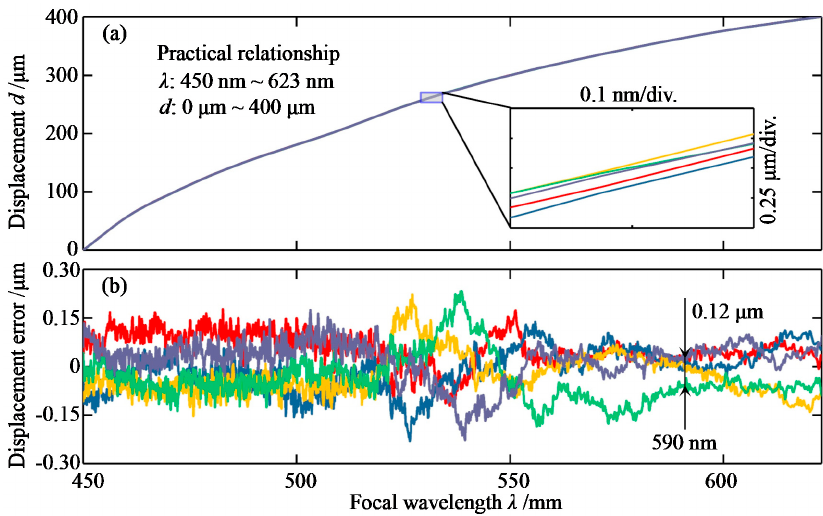
Figure 6. Calibration experimental results: ( a ) Practical relationship between wavelength and displacement; ( b ) Displacement error vs. the focal wavelength.